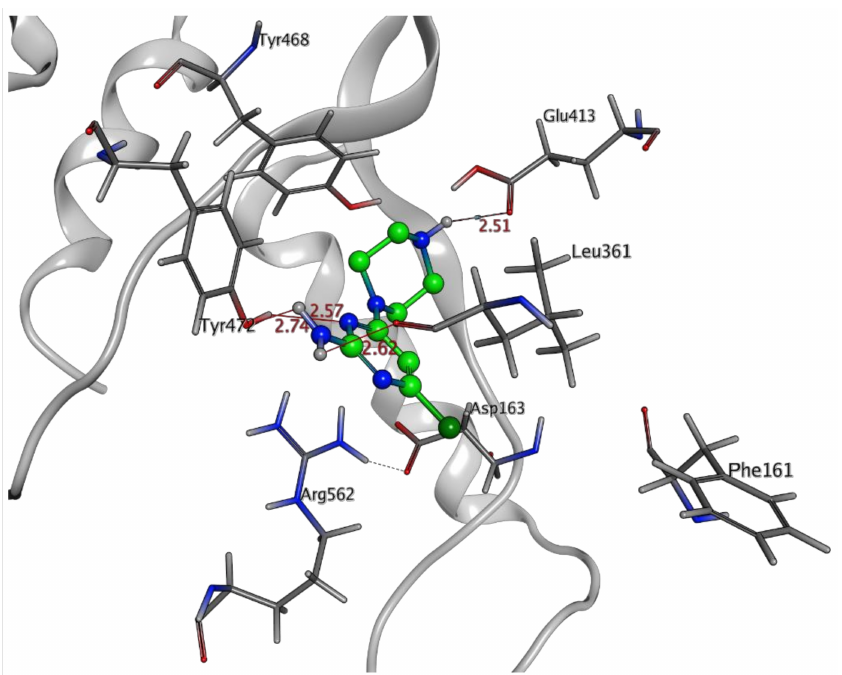
Figure 7. 3-Dimensional interaction diagram of the most potent compound 24 (green) presenting various hydrogen bonds (red lines) and hydrophobic interactions with the crucial residues (Glu413 and Leu361) of β -glucuronidase responsible for its potent inhibitory